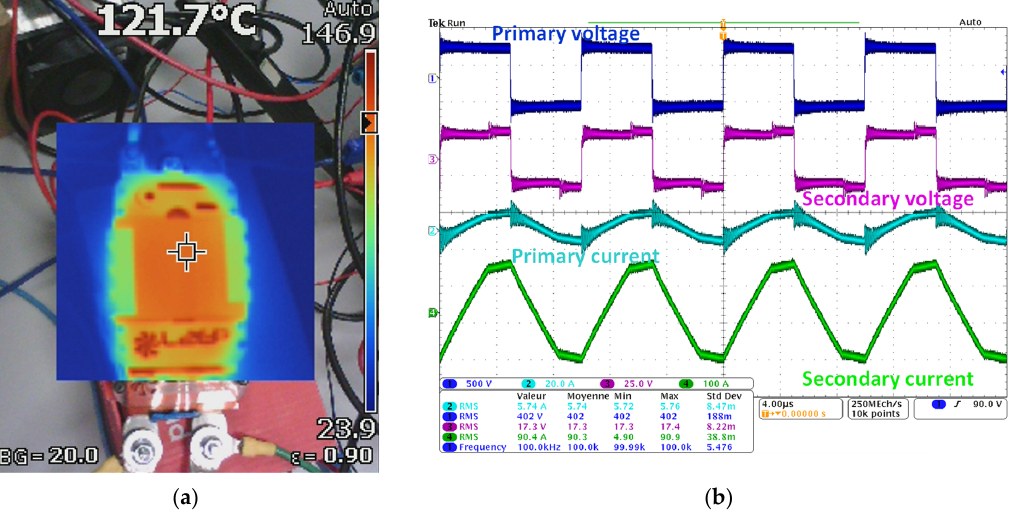
Figure 14. Thermal characterization—400 V (primary)/90.4 A (secondary): ( a ) temperature distribution; ( b ) voltage and current waveforms.